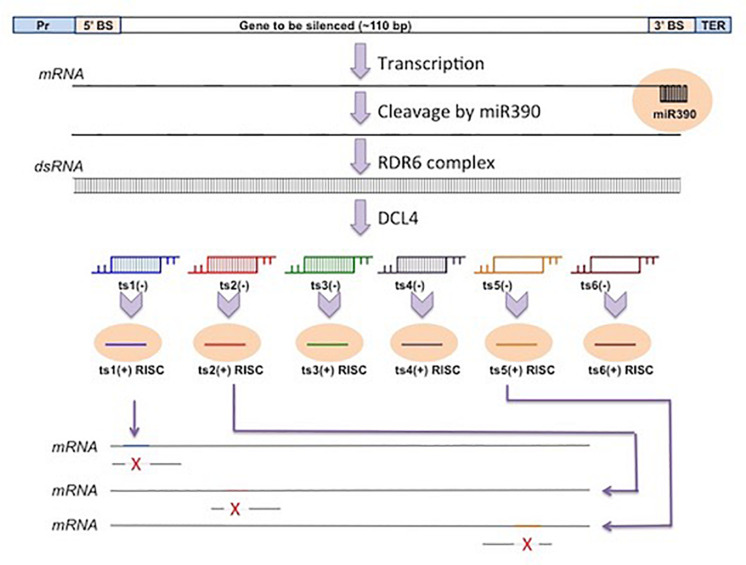
Schematics of miRNA induced silencing (MIGS) using miR390 as the initiator. A fragment of DNA is completely substituted by a hypothetical gene of 130 bp, which is flanked by 5′ binding site (5′BS) and 3′ binding site (3′BS) of the miRNA. Following cleavage by miR390-RISC, the cleaved mRNA is converted to dsRNA by RDR6 complex. This is diced by DCL4 to spawn the tasiRNAs (ts1 to ts6). The tasiRNAs slice the target mRNA (T) at appropriate site (shown as X). The other abbreviation used are Pr: promoter; TER: Transcription termination sequence; + and −: both strands of the tasiRNA; cs: complementary sequence.